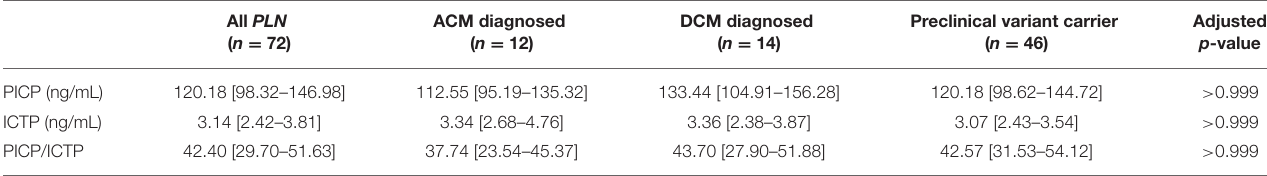
TABLE 2 | Fibrosis biomarkers concentrations in all PLN variant carriers ( n = 72) or divided into ACM diagnosed ( n = 12), DCM diagnosed ( n = 14) or preclinical pathogenic variant carriers ( n = 46). All